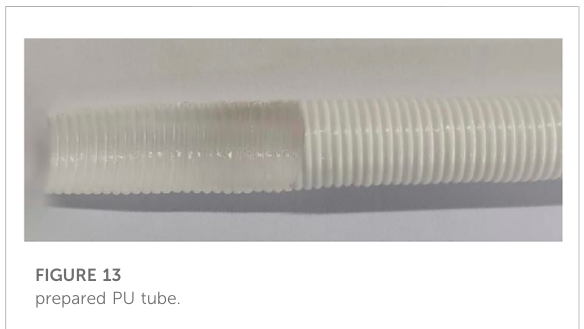
FIGURE 13 prepared PU tube.